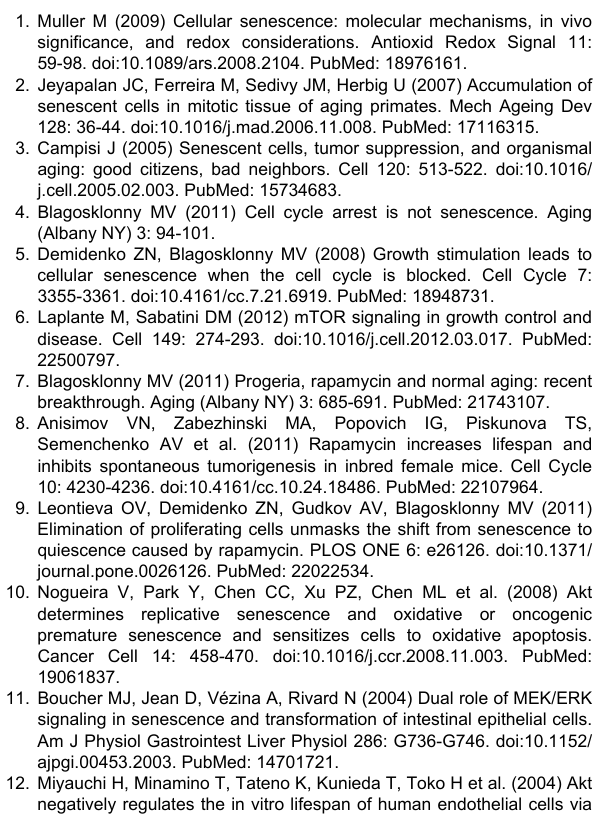
Figure S1. Radiation-induced accelerated senescence is not attenuated by p42/p44 MAPK inhibition. Subconfluent HPAEC were pretreated with 10 μM U0126 or vehicle (DMSO) for 30 minutes. Cells were either sham-irradiated (control) or exposed to 10 Gy X-rays and then incubated until time of assay. Representative pictures of SA-β-gal staining at 4 days post-irradiation are shown.